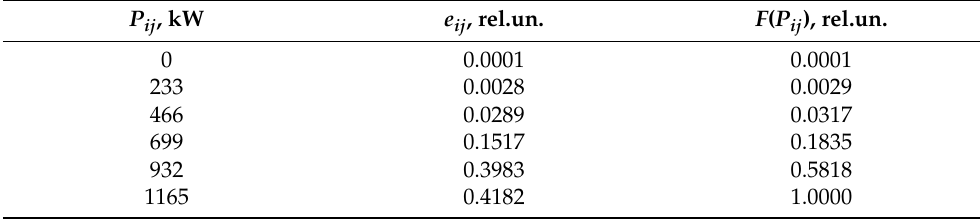
Table 13. Static series of the probability distribution of ordinates of the initial group ELC without using frequency